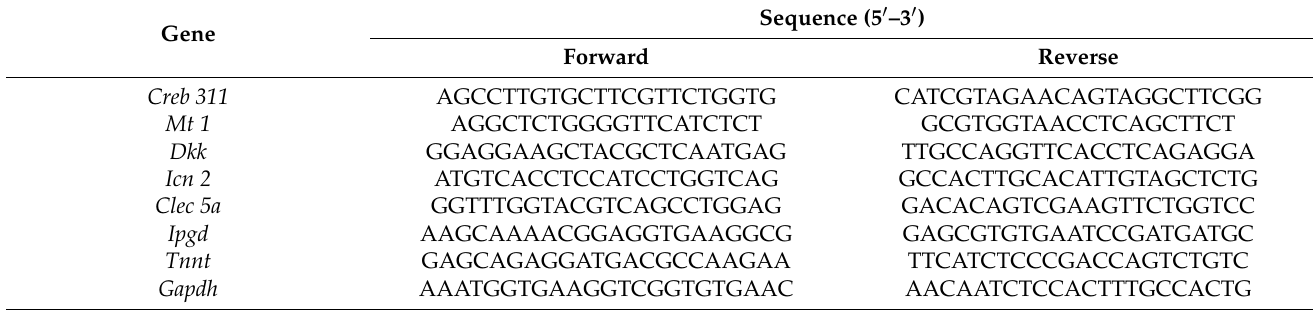
Table 1. List of primers used in qRT-PCR